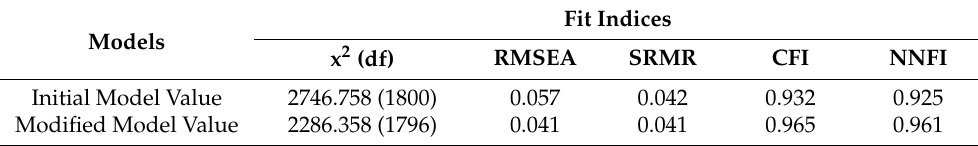
Table 1. Initial and Modified Models Fit Indices of Multilevel Confirmatory Factor